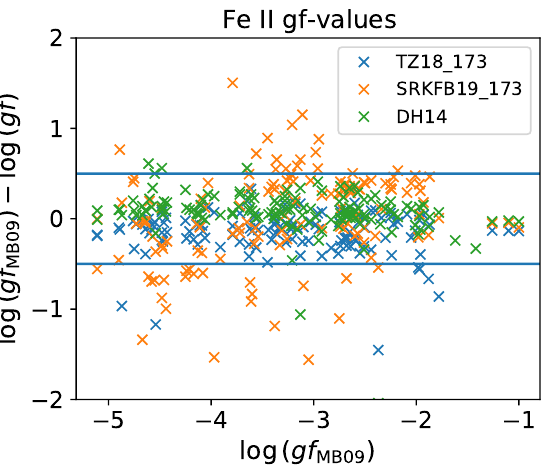
Figure 13. Comparison of observed gf -values for Fe II (MB09) [47] with those calculated from atom_TZ18_173, atom_SRKFB19_173, and Ref. [43] (DH14).